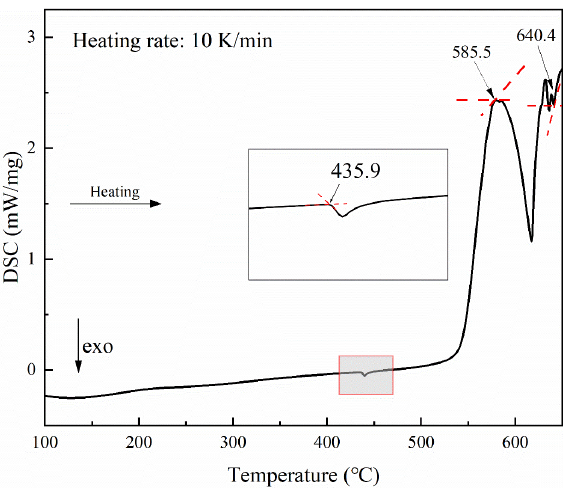
Figure 1. Differential thermal analysis (DTA) profiles of as-cast Mg-4Al-1.5Si alloy.